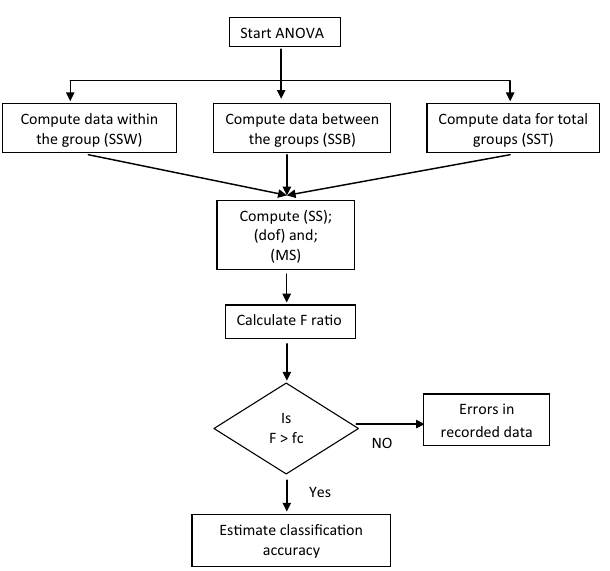
Fig. 3. Block diagram for analysis of variance steps.